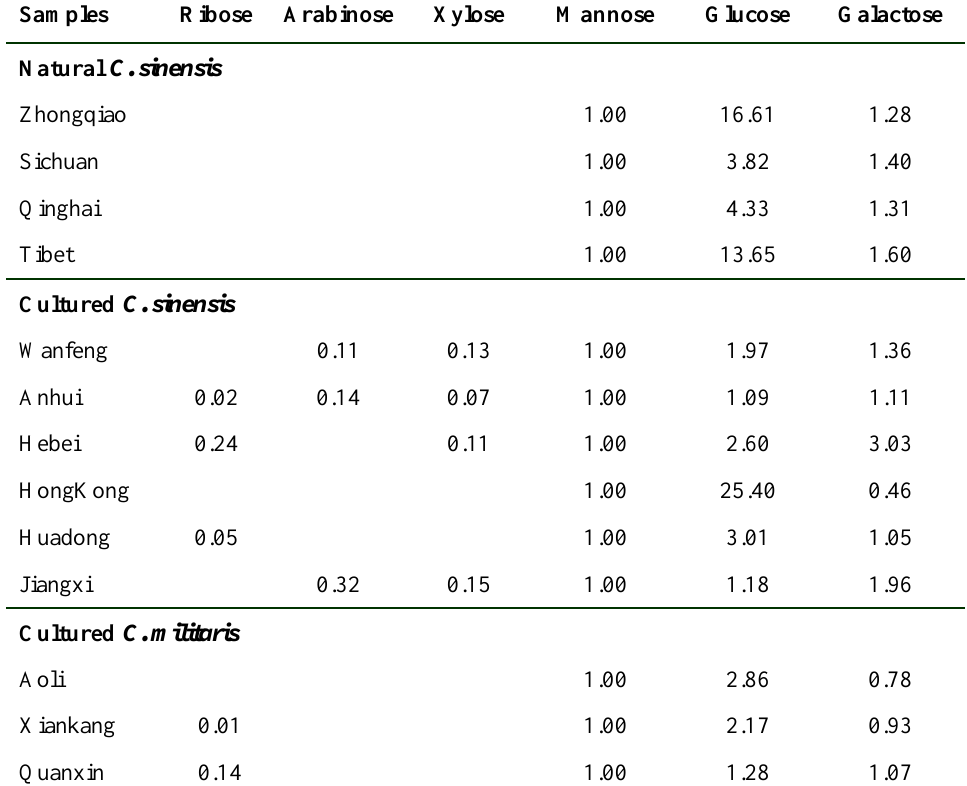
Table 4. Molar ratio of compositional sugars of polysaccharides in natural and cultured Cordyceps .